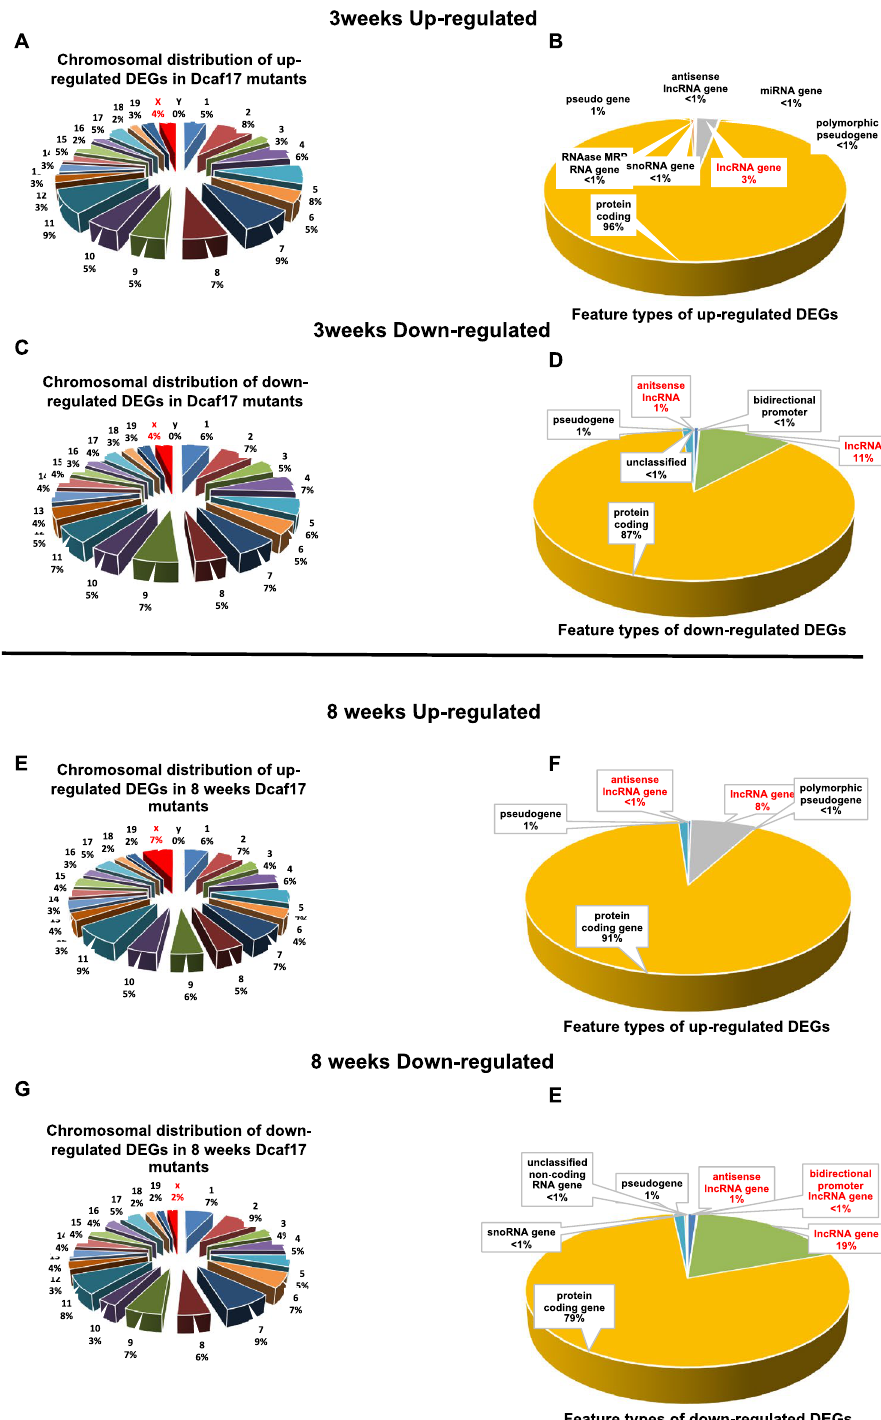
Figure 2. Chromosomal distribution (left) and feature types (right) of DEGs in testes of 3 weeks and 8 weeks old mice.( A,C ) the DEGs are distributed on all the chromosomes but the Y-chromosomes. Note, in the 3 weeks age group lncRNAs are among the feature types of the DEGs and are higher in proportion among the down- regulated DEGs, ( B,D ). ( E,G ) in the 8 weeks age group the DEGs are distributed on all the chromosomes but the Y-chromosomes. Note, lncRNAs are among the feature types of the DEGs and are higher in proportion among the down-regulated DEGs, ( F,E )